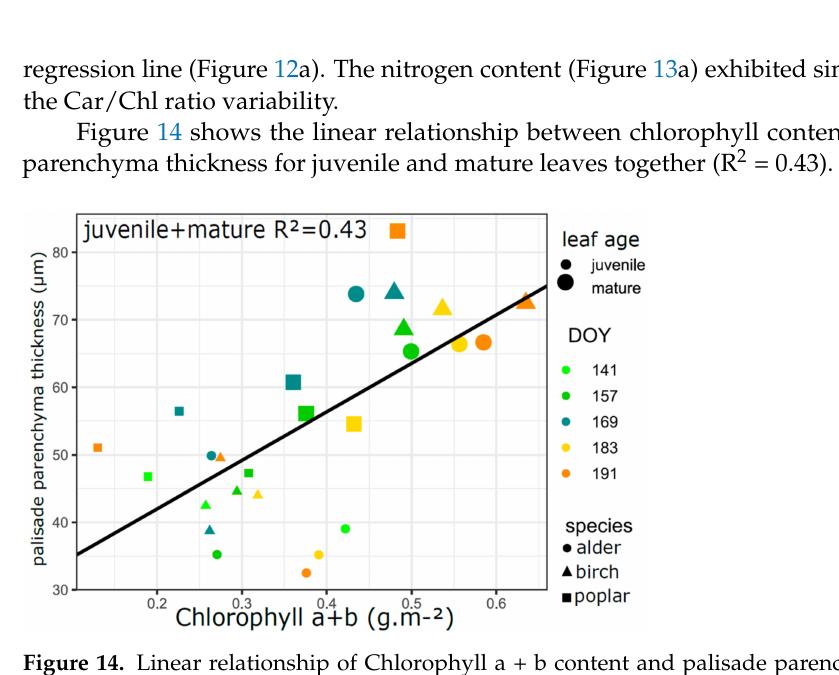
Figure 14. Linear relationship of Chlorophyll a + b content and palisade parenchyma thickness. Different symbol size corresponds to leaf age—juvenile (small), mature leaves (large), different colors correspond to DOYs during the season, different symbols correspond to tree species. R 2 —coefficient of determination of linear